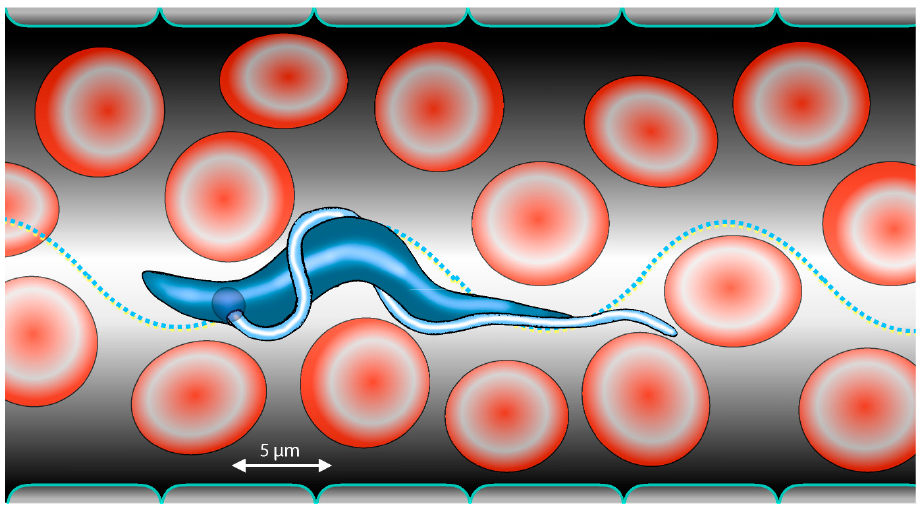
Figure 1. Motion of trypanosomes in the blood of their mammalian host is adapted to the crowded microenvironment. The presence of obstacles in the form of blood cells accelerates speed and improves directionality of parasite